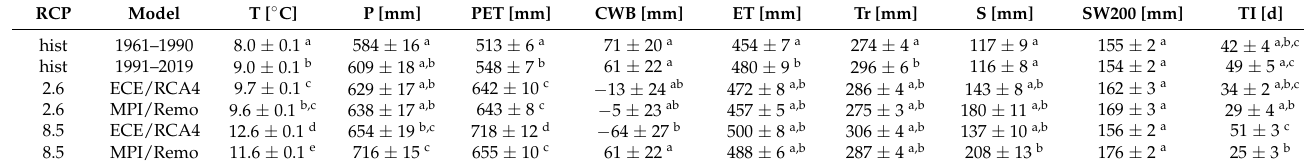
Table 2. Averages (all plots) of historical time-periods 1961–1990, 1991–2019, and 2071–2100 for the climate scenarios, with temperature (T), precipitation (P), FAO grass reference evapotranspiration (PET), climate water balance (CWB), actual evapotranspiration (ET), transpiration (Tr), interception (I), seepage (S), plant-available soil water down to a depth of 200 cm (SW200), and dry days (days with transpiration index <0.7 (TI)). Significant differences ( p < 0.05) are indicated by different letters (a,b,c,d,e).